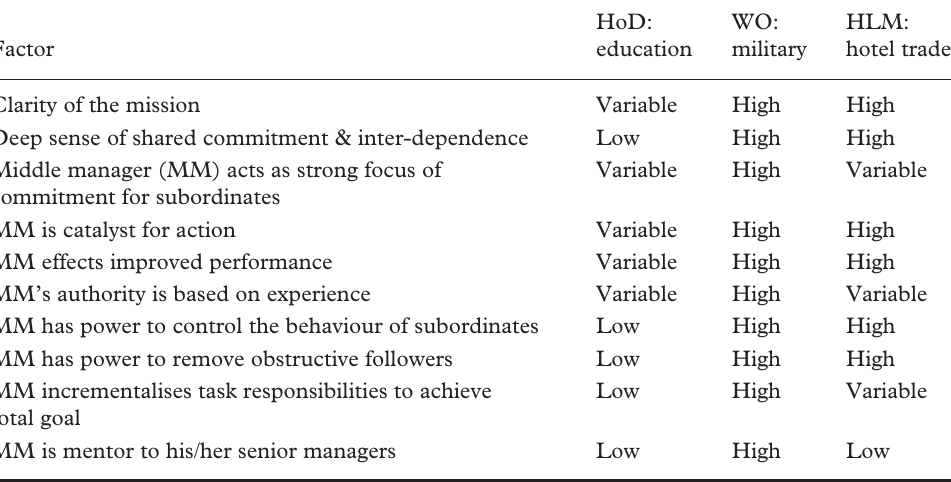
HoD: WO: HLM: education military hotel trade